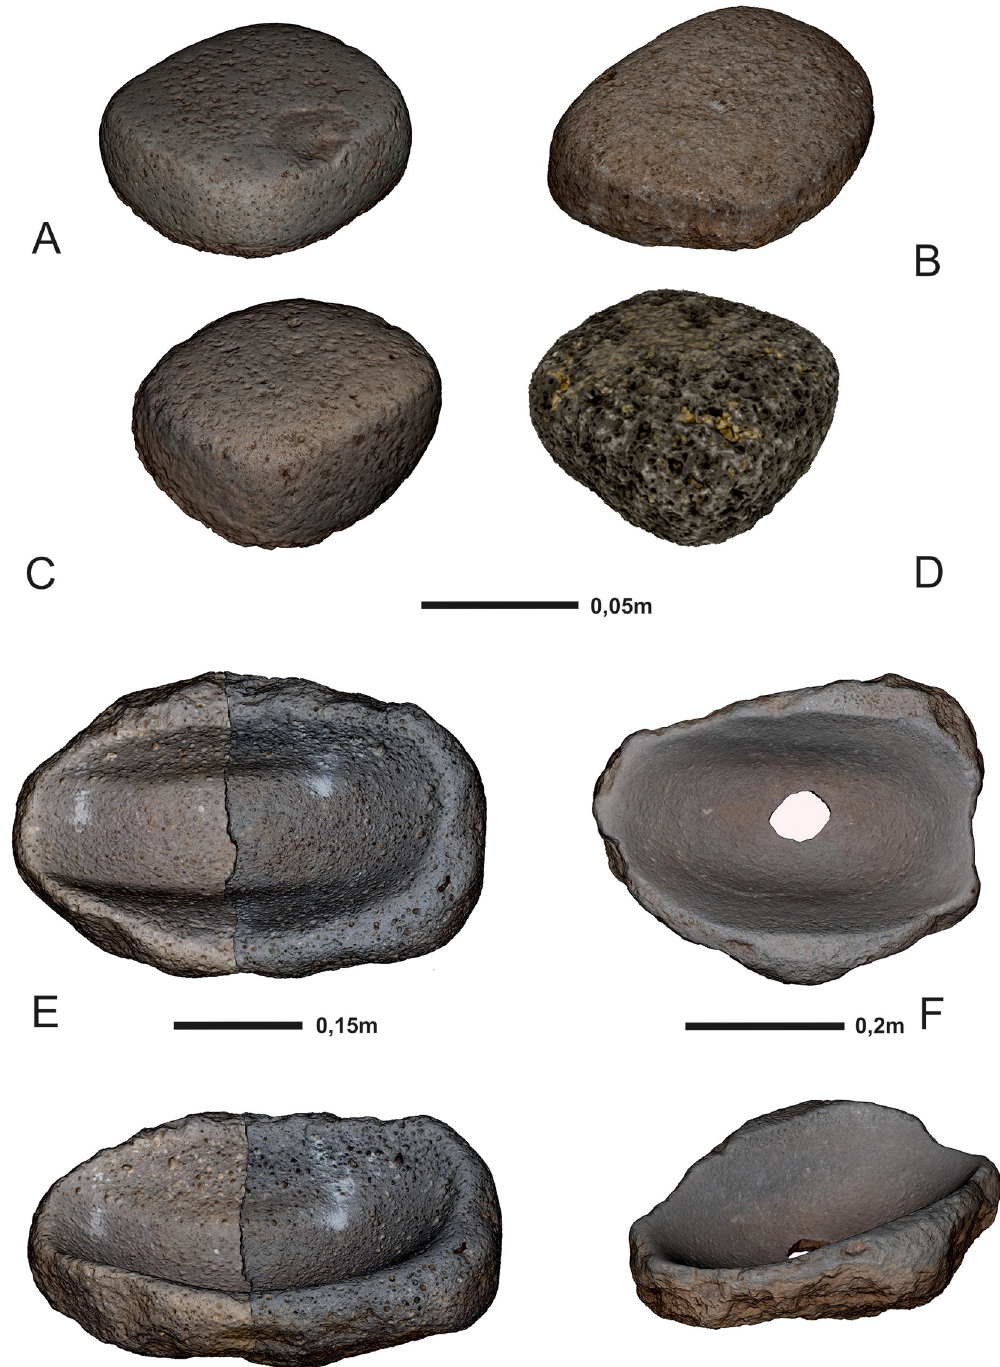
Fig 7. Grinding tools from Go¨bekli Tepe. (A), (C) Neolithic handstones of type 1; (B) Neolithic handstone of type 2; (D) Experimental handstone of type 1, produced as copy of (C); (E, F) Neolithic grinding bowls (German Archaeological Institute, 3D-models H. Ho¨hler-Brockmann and N.